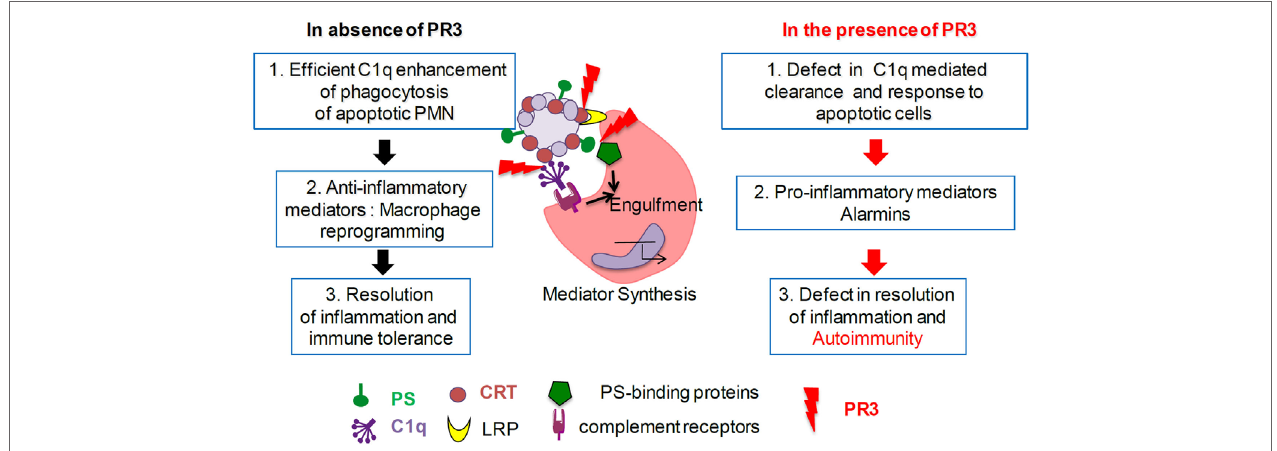
FigUre 6 | Proteinase 3 (PR3) expression on apoptotic cells decreases C1q-mediated phagocytosis. In absence of membrane PR3 , C1q opsonization of apoptotic cells through apoptotic cell-associated molecular pattern recognition [such as phosphatidylserine (PS), calreticulin (CRT), and others] enhances phagocytosis through macrophage receptors (such as LRP and others) and triggers anti-inflammatory responses leading to the resolution of inflammation. In the presence of membrane PR3 , expression on apoptotic cells, PR3 that binds PS, CRT, and C1q, could interfere with the multimolecular complexes at the interface between apoptotic neutrophils and macrophage, delaying or affecting phagocytosis of apoptotic cells, activating a pro-inflammatory immune response favoring